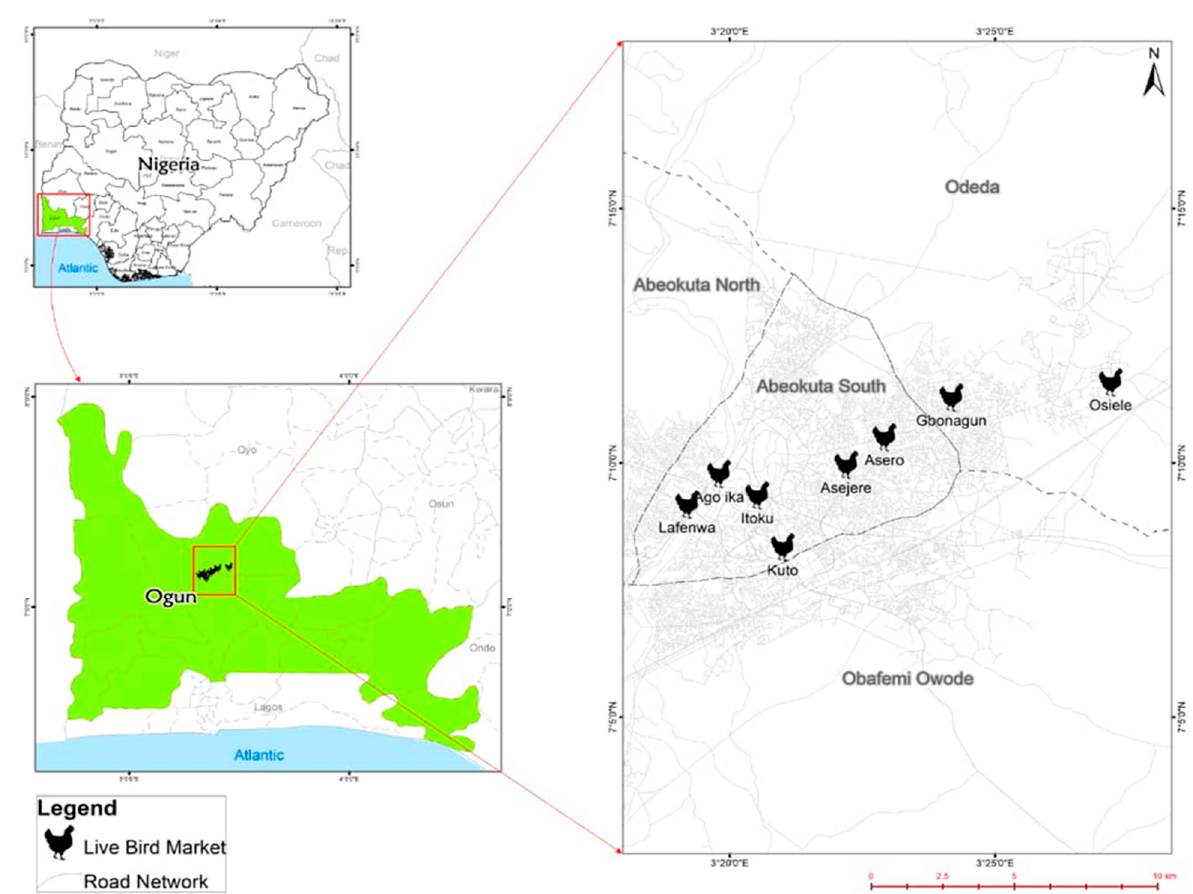
Figure 7. Spatial distribution of LBMs surveyed in Abeokuta, Ogun State.